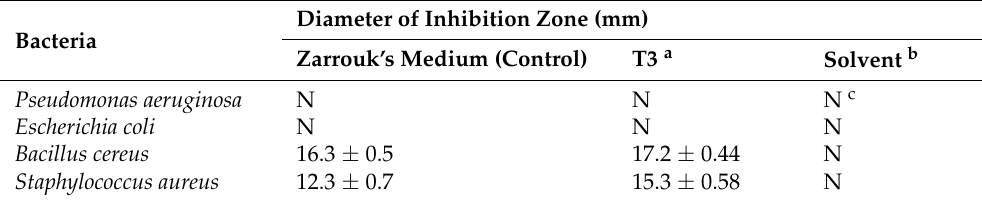
Table 3. The inhibition zone diameter (mm) measurement of different O. sancta crude extracts against pathogenic bacteria.